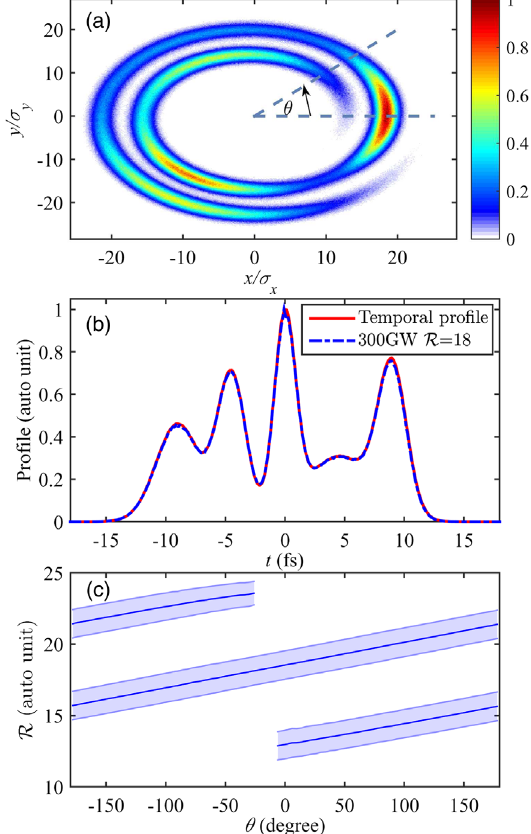
FIG. 4. Circular deflector results for longer electron beam: (a) spiral pattern at the final screen when the laser power is 300 GW; (b) actual and reconstructed beam current profiles with laser power 300 GW ( R ¼ 18 ); (c) the average ring radius along the polar angles. The shadow is the rms width of the